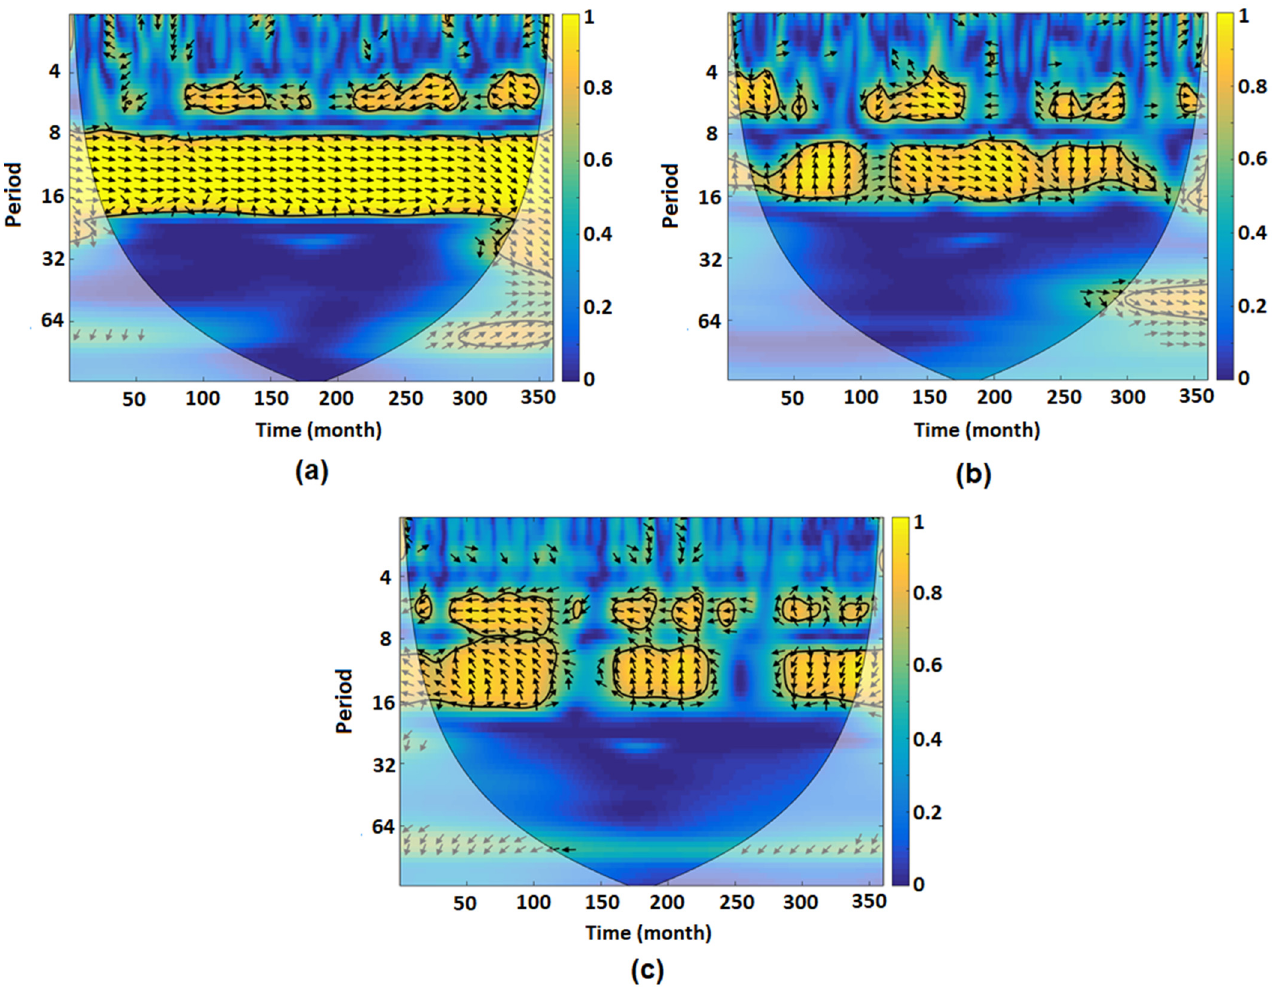
Figure 5. Wavelet transform coherence for the variables in the NC watershed between NDVI and ( a ) temperature, ( b ) precipitation, and ( c ) streamflow.